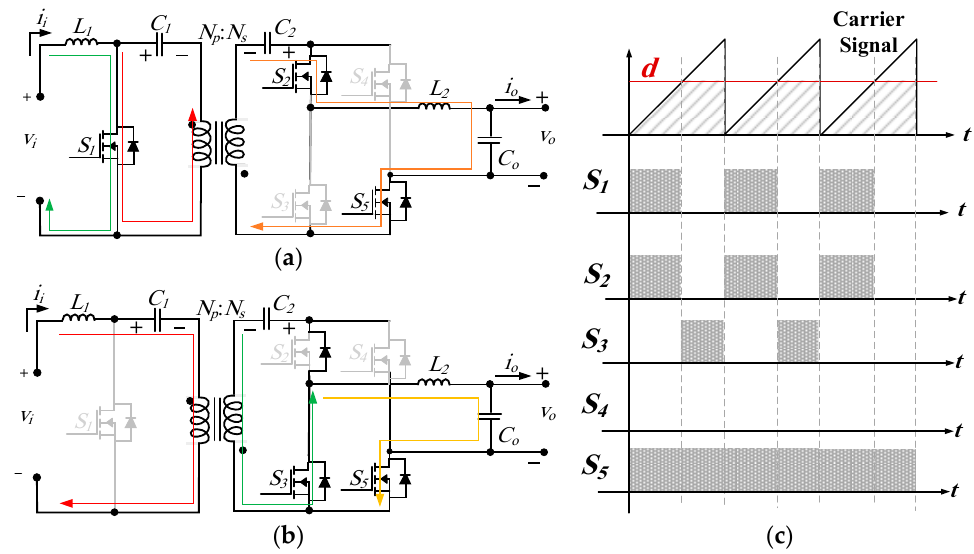
Figure 10. Cuk SM currents during Mode 1: ( a ) St dc1 , ( b ) St dc2, and ( c ) modulation scheme.